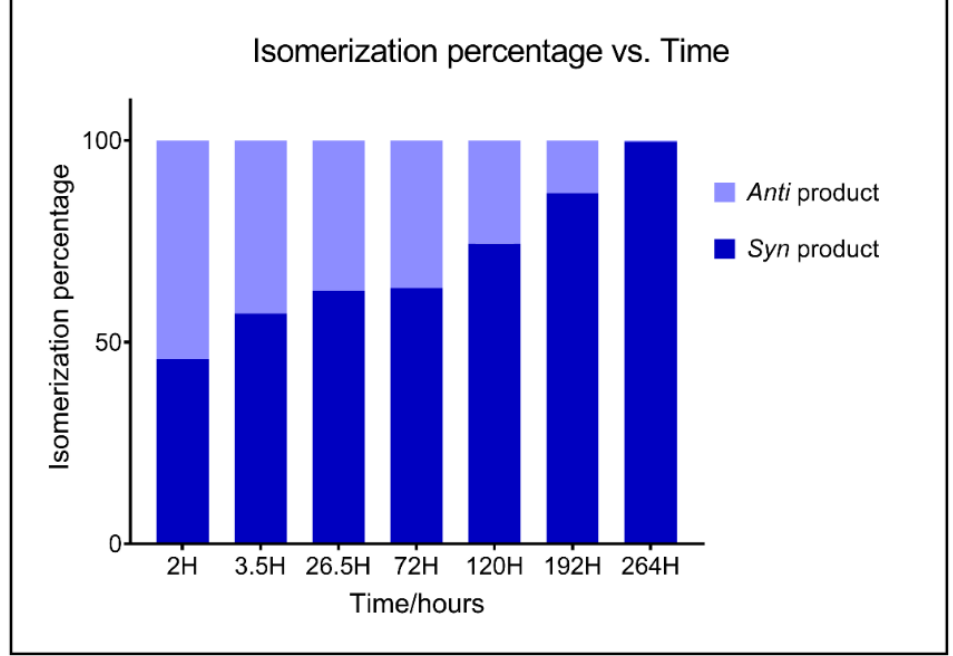
Figure 1. Percentage isomerization vs. time of ( Z / E )- N -hydroxy-1-(1 H -indole-3-yl)methanimine (compounds 2 and 3 ) under acidic medium.